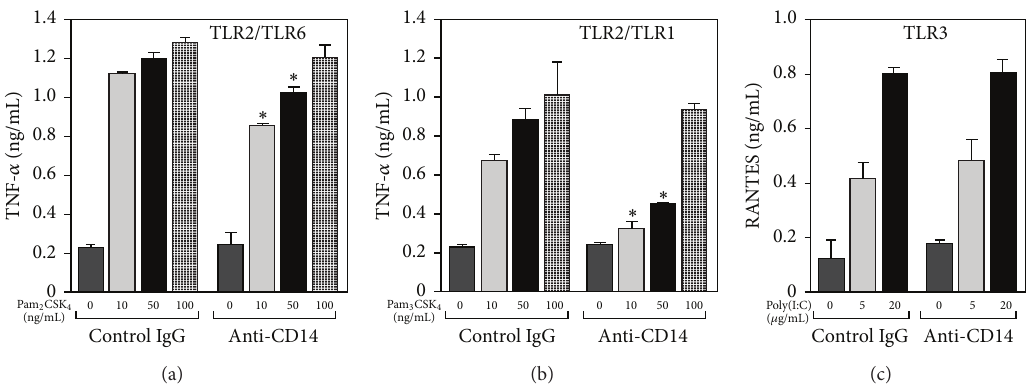
Figure 3: Effect of neutralizing CD14 on cytokine production during activation of TLR2/TLR6, TLR2/TLR1, and TLR3. RAW264 cells were pretreated with 10 𝜇 g/mL of the anti-CD14 antibody or isotype-matched control rat IgG2b (30min, 37 ∘ C) and exposed to indicated concentrations of Pam 2 CSK 4 (a) or Pam 3 CSK 4 (b) or poly(I:C) (c) in the presence of 10% FBS. Amounts of TNF- 𝛼 (a, b) and RANTES (c) were measured by ELISA tests in supernatants of the cells. Data shown are mean ± SEM form two or three experiments each run in triplicate. ∗ Significantly different from cells stimulated with a corresponding ligand concentration in the presence of control